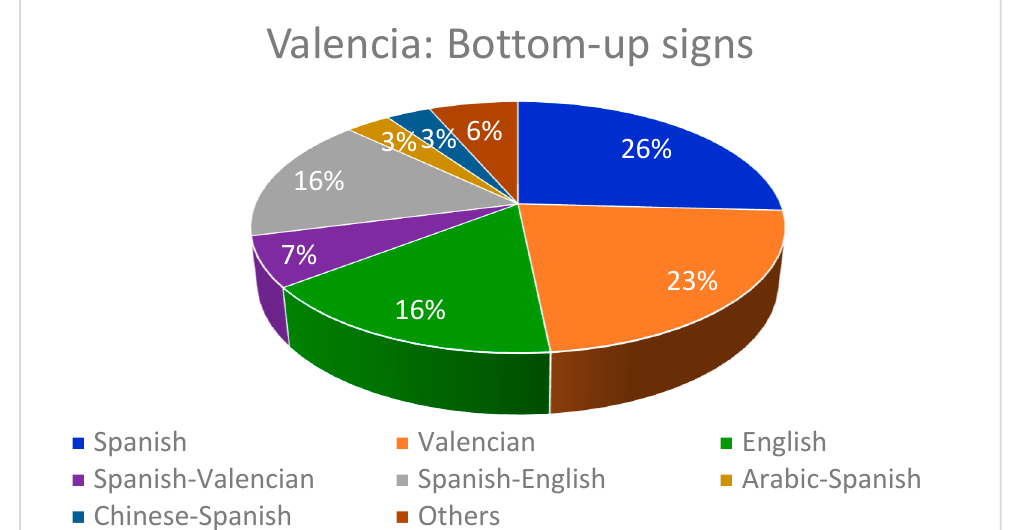
Figure 36. Valencia: Bottom-up signs.